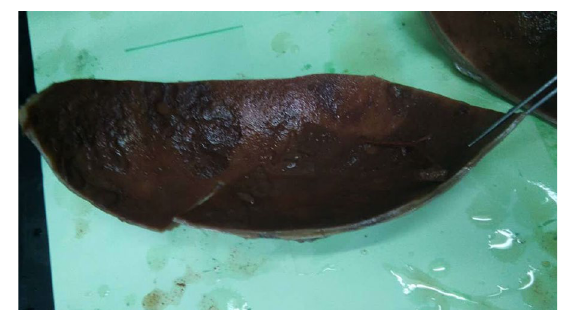
Fig. 3 Gross specimen of right orchidectomy. On cutting the specimen, presence of blood clots and necrotic materials within, no viable mass or solid area